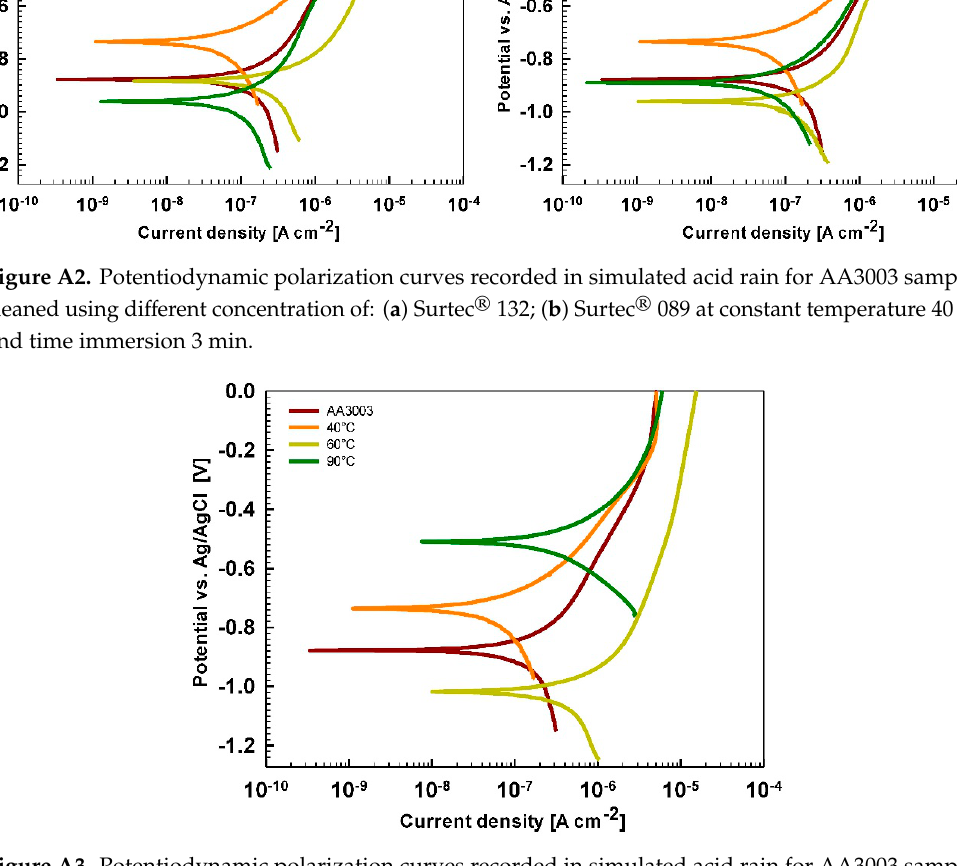
Figure A3. Potentiodynamic polarization curves recorded in simulated acid rain for AA3003 samples cleaned using 2% SurTec ® 132 and 0.5% SurTec ® 089 for 3 min at different temperatures.